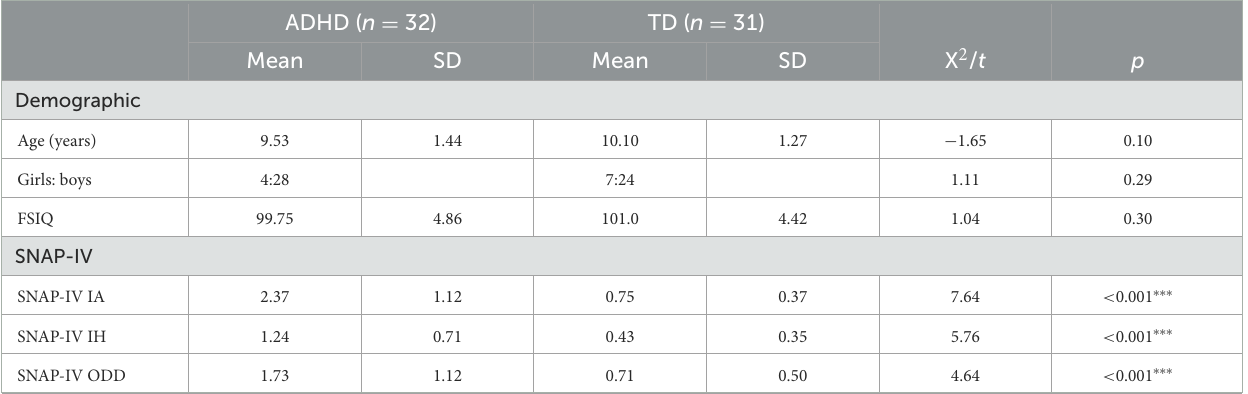
TABLE 1 Demographic and clinical characteristics of participants.